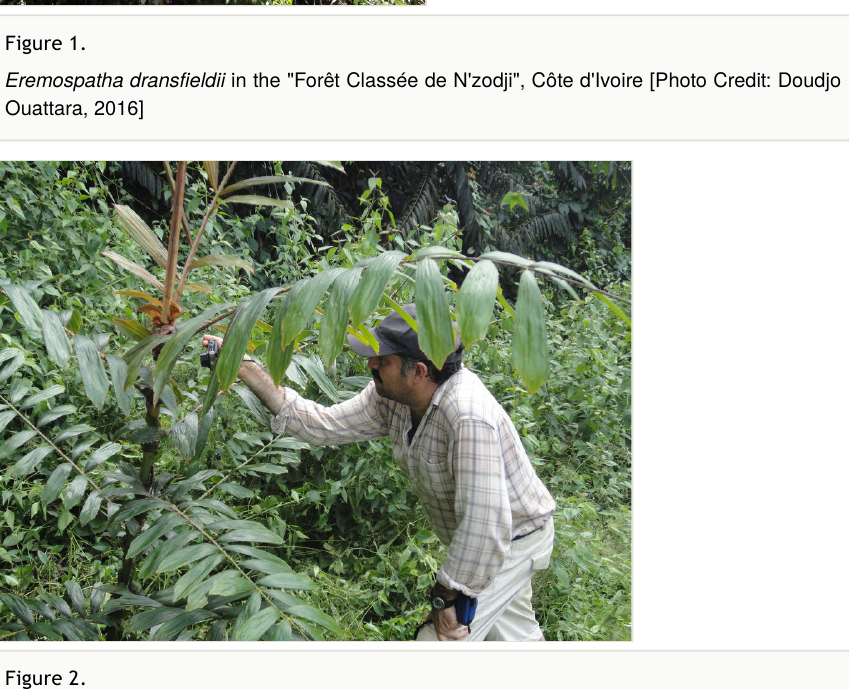
Figure 2. Dr. Fred Stau ff er photographing Eremospatha drans fi eldii in the "Forêt classée de N'zodji", Côte d'Ivoire [Photo Credit: Doudjo Ouattara,